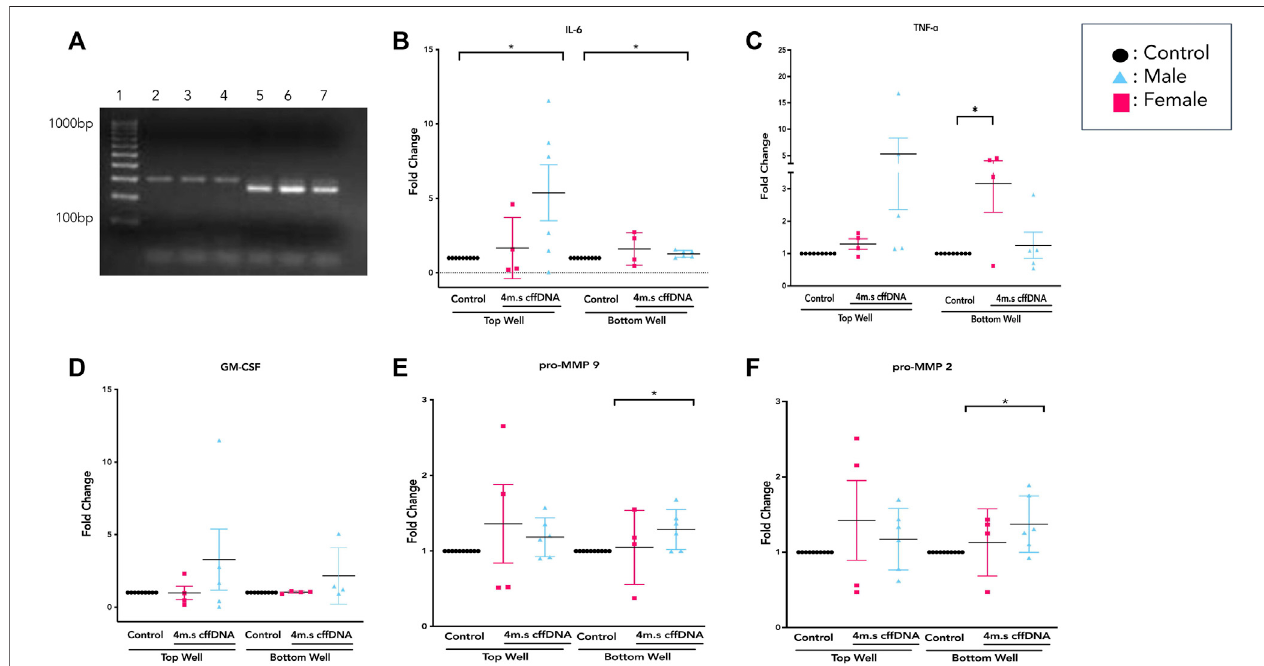
FIGURE 5 | Sex-speci fi c response of FM explants to 4 m.s cffDNA. (A) Example of PCR product gel shows that in lanes 2 – 4 the expression of SRY indicates a female fetus, whereas the expression of both SRY and ALT1 in lanes 5 – 7 indicated a male fetus. The fold change secretion, compared to no treatment control, of cytokinesinto theapical (top)well orbasal(bottom)well ofthetranswell fetal membrane explantafter treatment with4 m.s cffDNA at100 ng/ml. (B) IL-6, (C) TNF-alpha, and (D) GM-CSF (E) pro-MMP9 (F) pro-MMP2. Black — untreated control. Blue- male fetus, and pink — female fetus. n = 7 – 10 patients. * p = < 0.05 ** p = < 0.001.